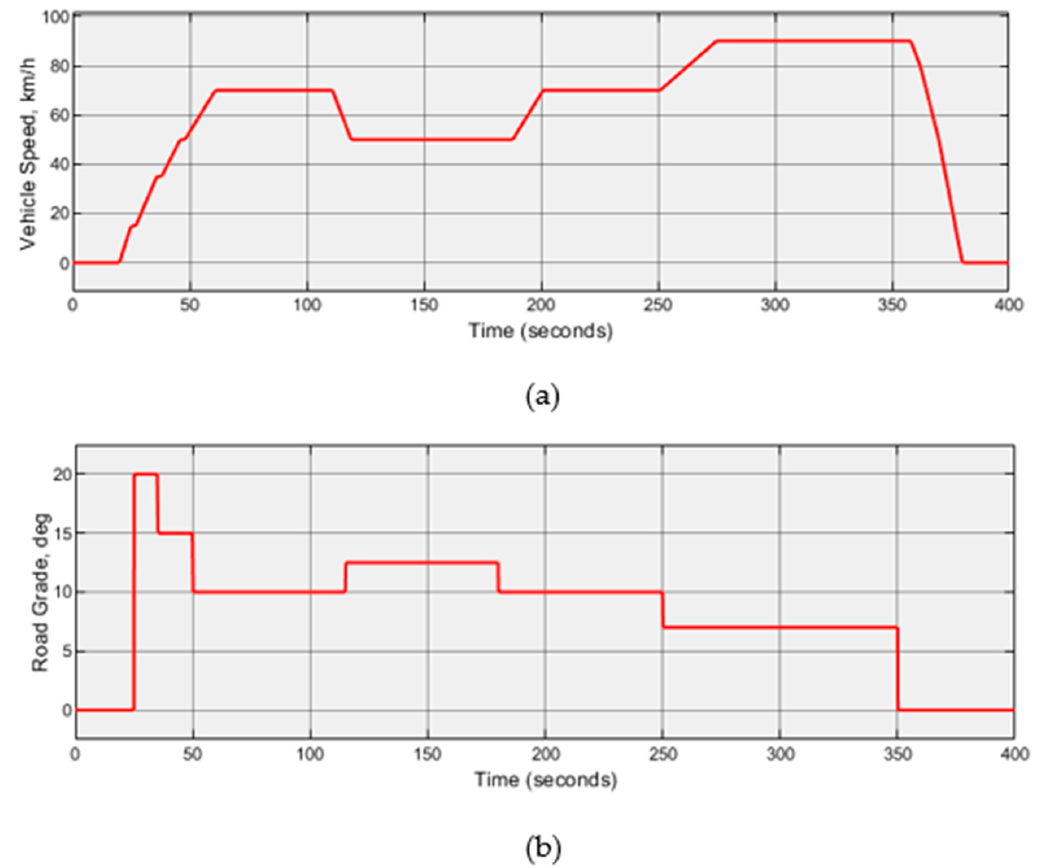
Figure 13. Vehicle input speed associated with road grade information: ( a ) Economic Commission for Europe (ECE) Extra-Urban driving cycle and ( b ) Road grade distribution.